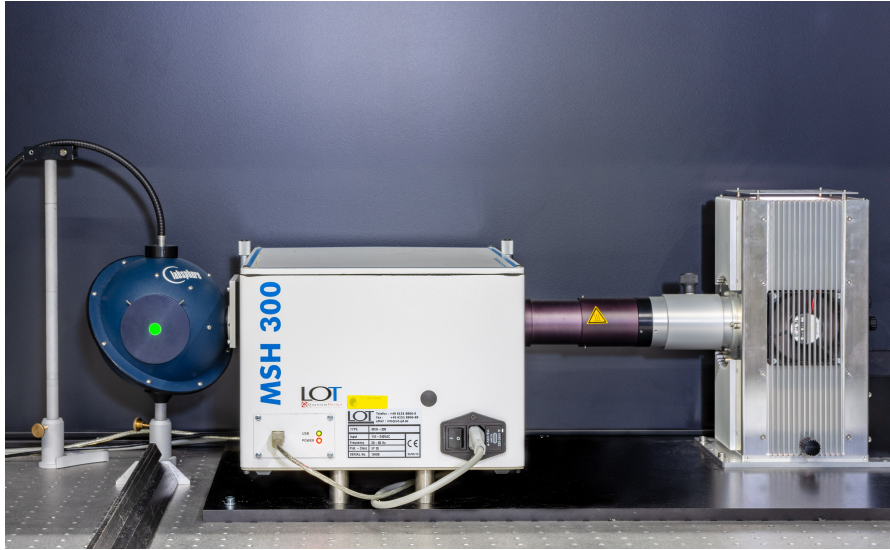
Figure 4. Image representation of the monochromator setup used in this